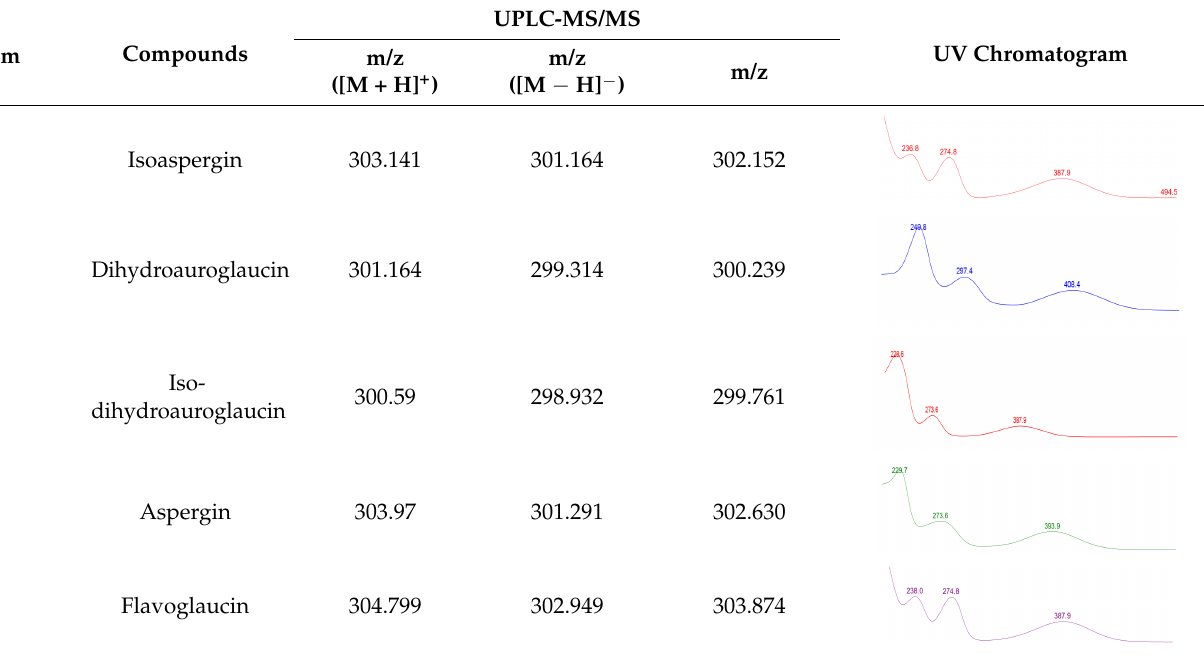
Table 4. Molecular weights and UV–Vis spectrum of secondary metabolites produced by Eurotium cristatum